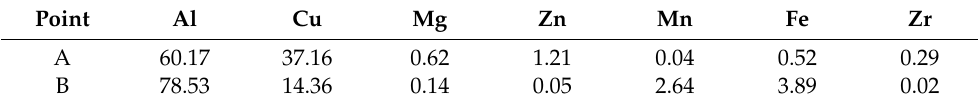
Figure 3. The SEM image ( a,b ) and EDS elemental map images of the Al-Cu-Li alloy ingot. Table 1. EDS spectrum analysis of the Al-Cu-Li alloy ingot (at.